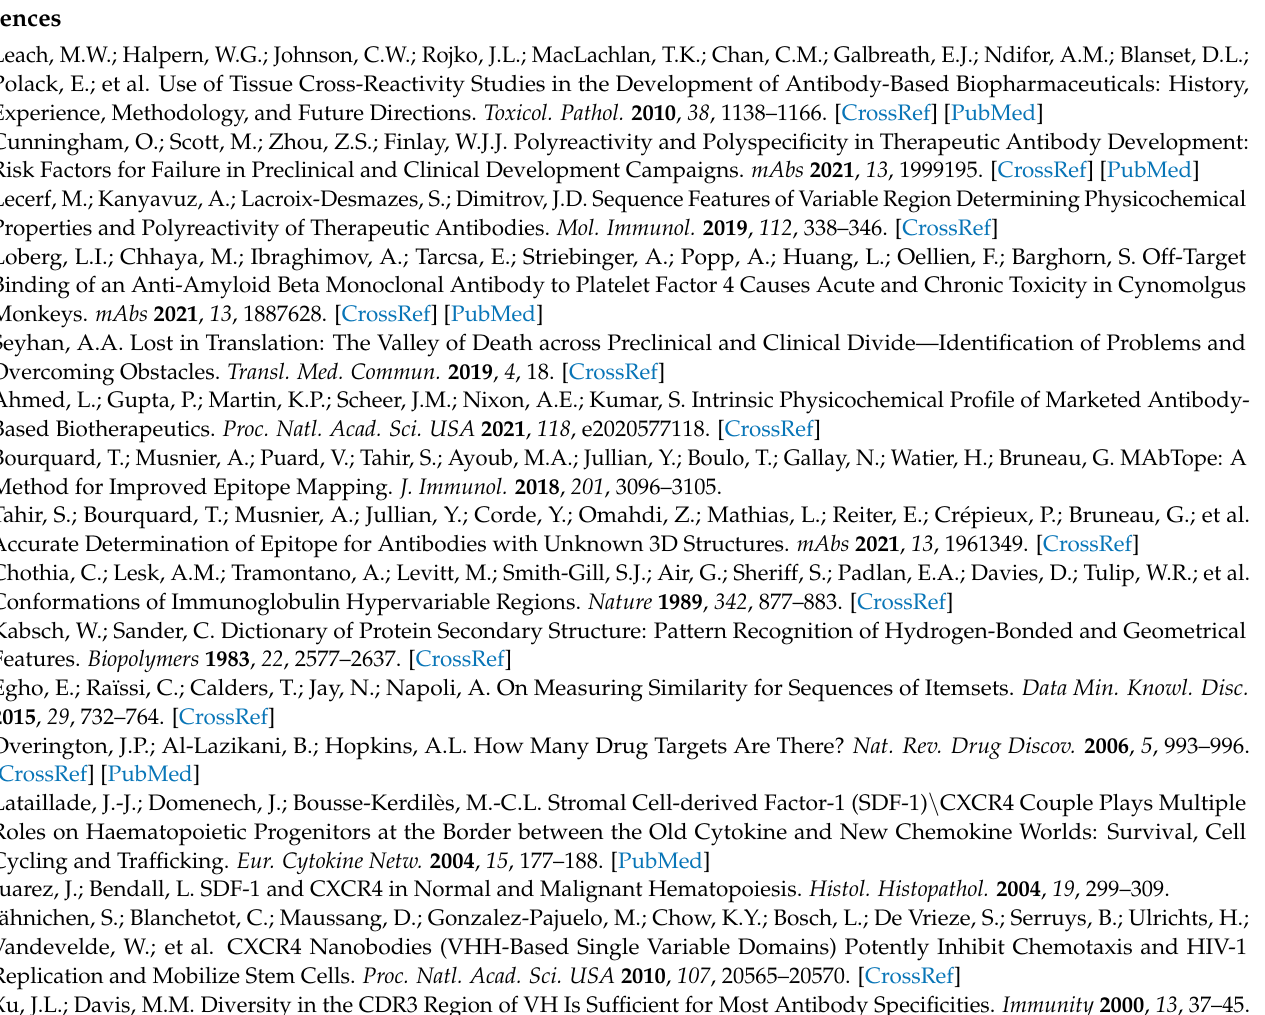
Figure A4. 238D2, 3SM5, 4N1H, and anti-ovalbumin Nb do not cross-react, neither on the vasopressin 2 receptor, nor on the luteninizing hormone receptor. HEK293FT cells transiently expressing YPET-fused β -arr2 and either RLuc8-V2R ( A ) or Rluc8-LHR ( B ) were incubated with 1 µM of each Nb. The β -arr recruitment to the receptors was induced by 10 nM DAVP ( A ) and 3 nM hCG ( B ), respectively.